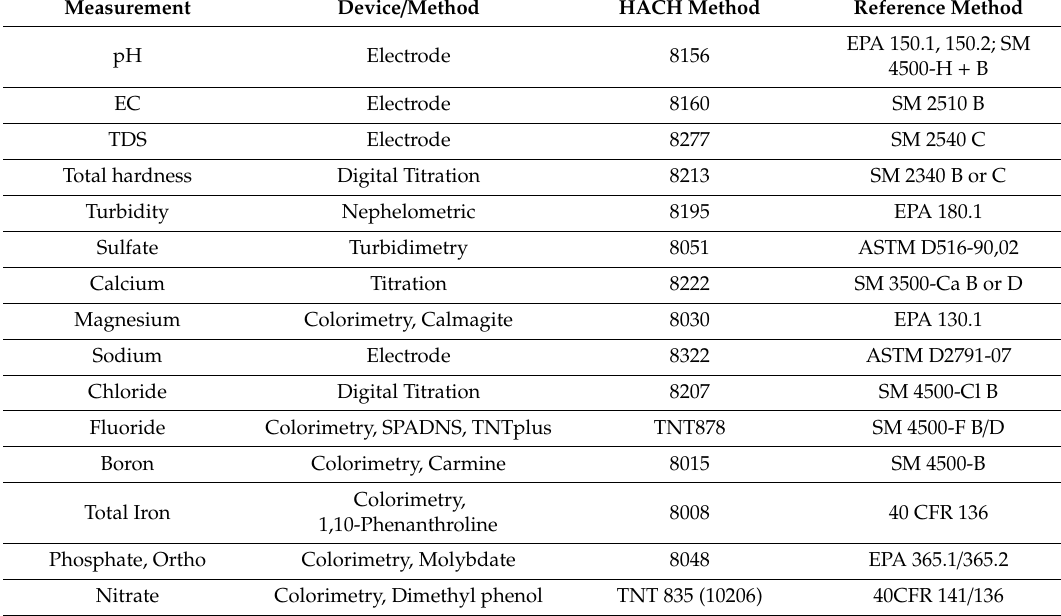
Table 2. Methods utilized in laboratory analysis of water